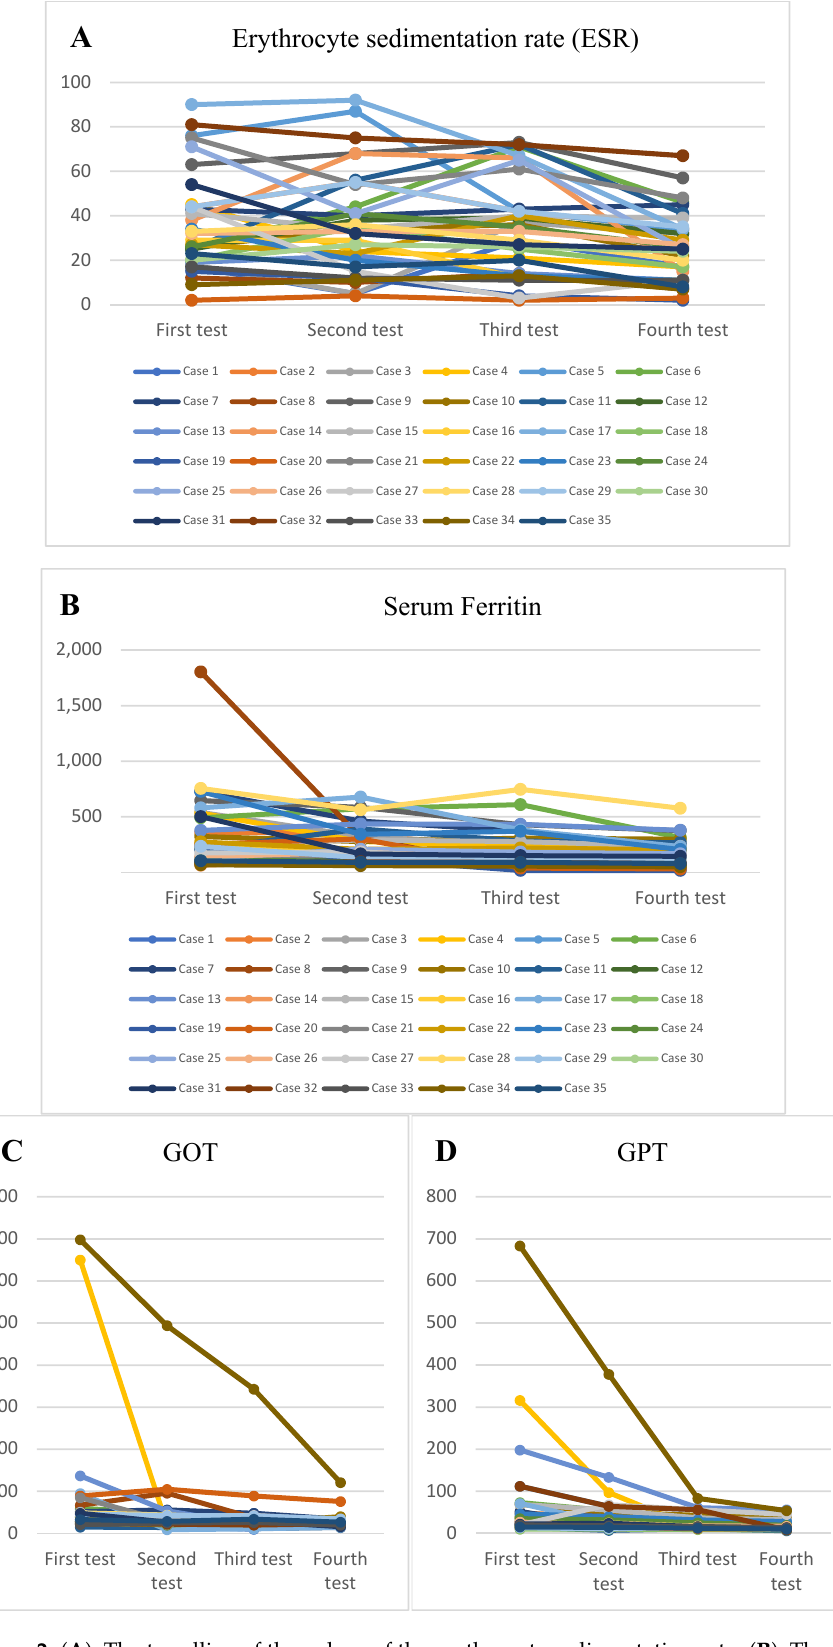
Figure 2. ( A ). The trendline of the values of the erythrocyte sedimentation rate. ( B ). The trendline of the values of serum ferritin. ( C ). The trendline of the values of GOT. ( D ). The trendline of the values of GPT. During the hospitalization, two of the patients had involvement of the renal system, as shown by an elevated creatinine level. In addition, a proteinuria was detected during the urinalysis of 34.28% of the cases, and hyperalbuminemia was observed in 17 patients (48.57%). Glutamic oxaloacetic transaminase (GOT) and glutamic pyruvic transaminase (GPT) enzymes were typically increased in 63% of cases (Figure 2C,D), with GOT and GPT levels over 70 U/l. ( p = 0.01), in parallel with the elevation of the inflammatory markers and the D-dimer, progressively decreasing after a median of 5 days of treatment, as well as high triglyceride values (Figure 3B).